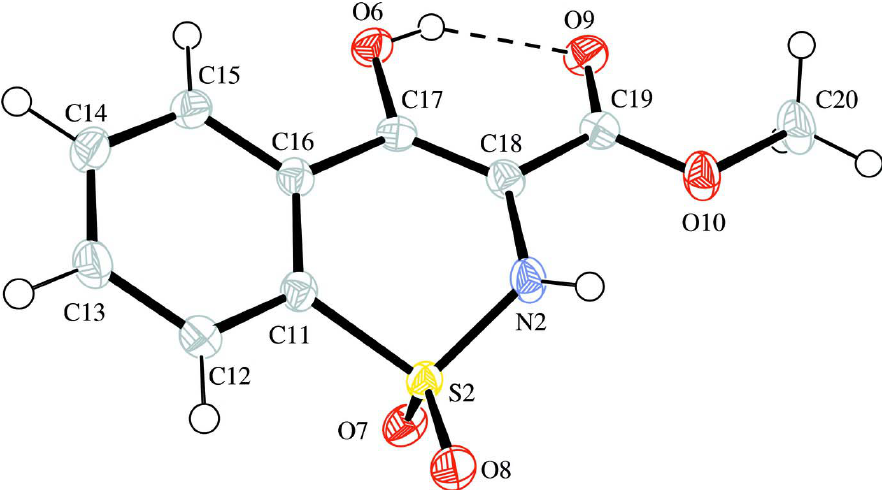
Figure 2 ORTEP - 3 (Farrugia, 1997) drawing of molecule b with displacement ellipsoids plotted at 50% probability